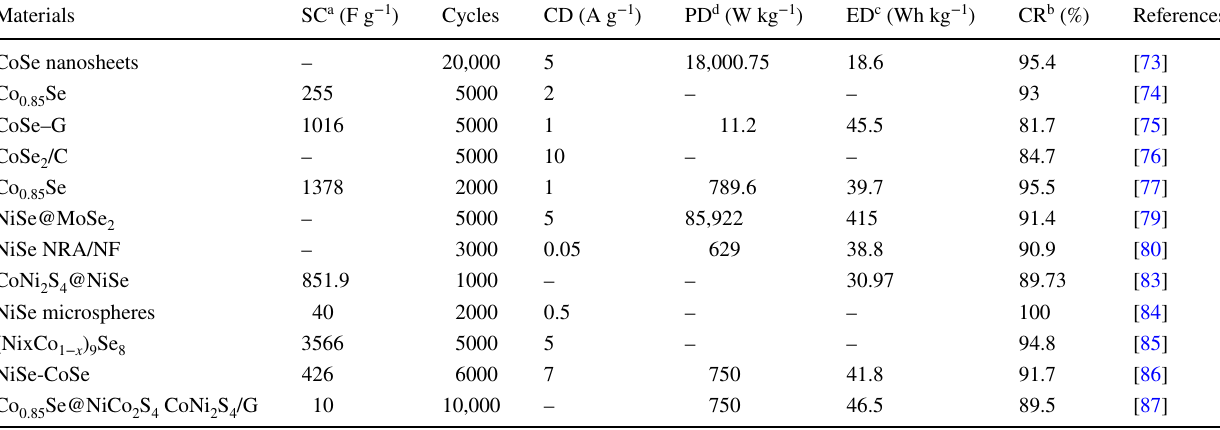
Table 2 Transition-metal sulfides based on graphene or graphene derivatives for